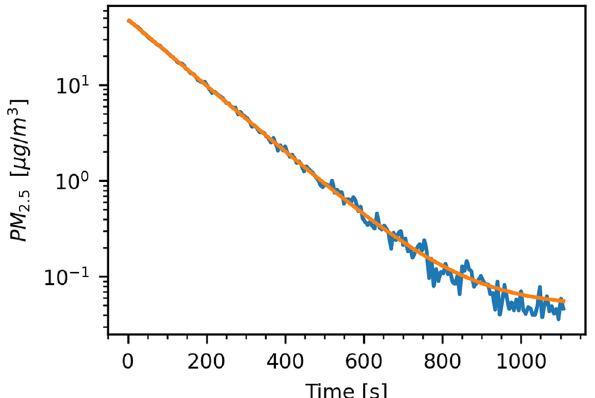
Figure 8. Removal of aerosols from the room. The original data is shown in blue. The orange curve is an exponential model fitted to that data.